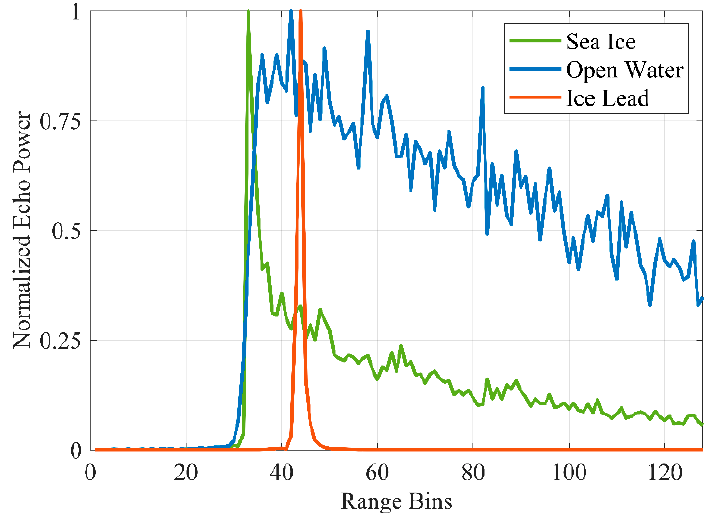
Figure 4. HY-2B radar altimeter waveform example of the open water, ice lead, and sea ice. Pulse Peakiness (PP): PP is the maximum power value ratio to the mean waveform power, which is the same definition as in Jiang et al. [32]. In order to reduce the impact of noise, an improved PP calculation formula, as shown in Equation (1), was used, where max ( Power ) is the maximum value in the waveform from bin 21 to bin 88, and Power ( i ) is the power value in bin i . PP is larger on smooth surfaces and smaller on rough surfaces.